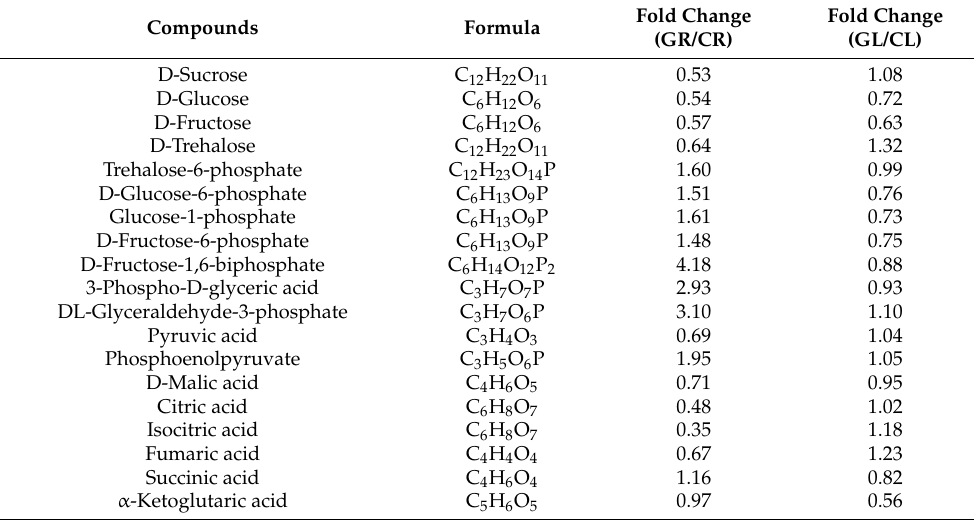
Table 3. Differential metabolites associated with energy metabolism.